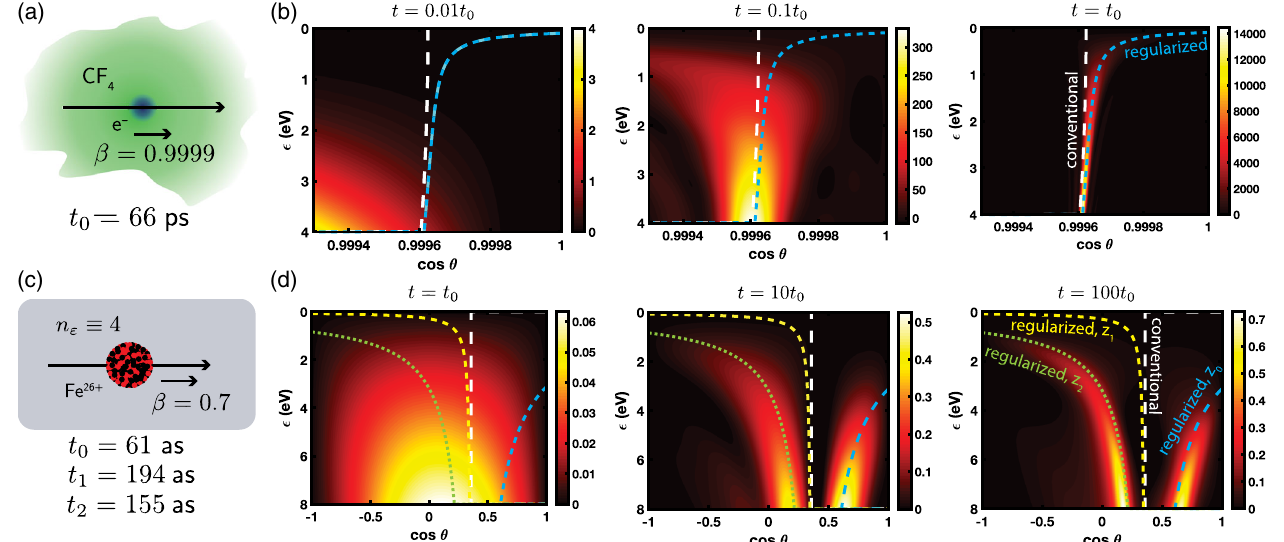
FIG. 2. Nonperturbative self-energy-induced modifications to Cherenkov radiation in weakly and strongly coupled regimes. (a) [respectively, (c)] An electron propagating at velocity β ¼ 0 . 9999 (respectively, β ¼ 0 . 7 ) in a chamber filled with CF 4 gas (respectively, in a material of constant index equal to 4) emits a photon with spectral angular density ½ð ∂ 2 p 1 Þ = ð ∂ ε ∂ u Þ(cid:2)ð t Þ , where u ¼ cos θ shown in (b) [respectively, (d)] at different times. The gradual narrowing of the Cherenkov energy-angle relation for long times is a direct consequence of the time-energy uncertainty